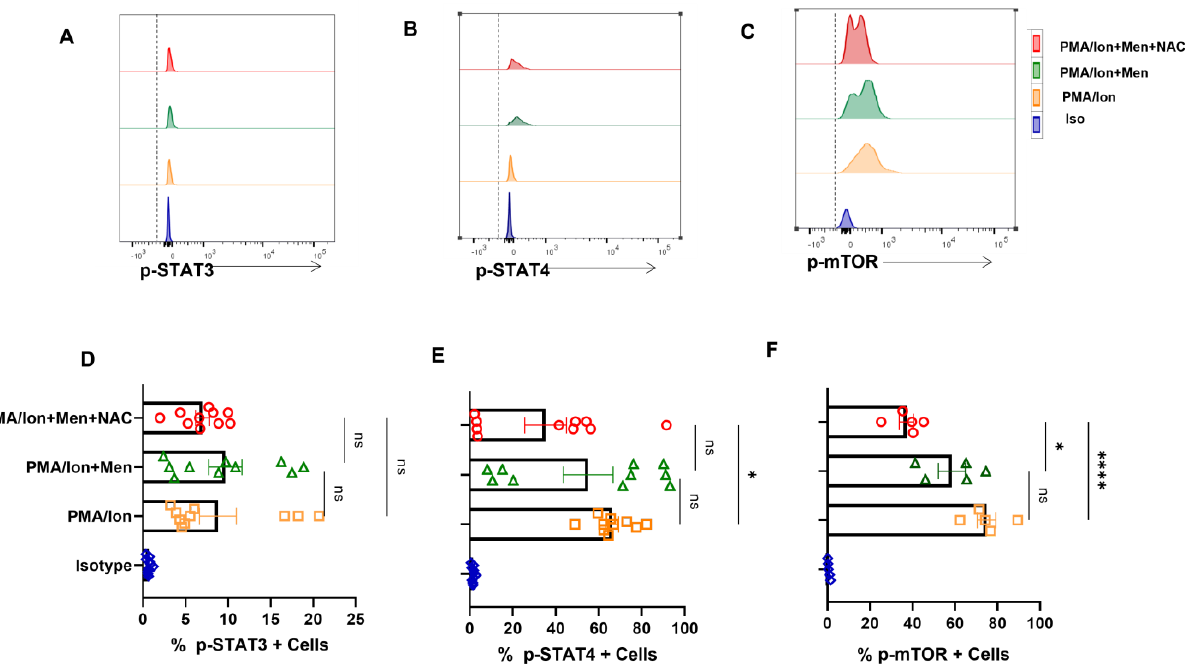
Figure 5. Antioxidant alters expression of p − STAT4 and p − mTOR from SLE CD8 + T cells. CD8 + T cells were isolated from the PBMCs of SLE patients and treated with 2.5 μM menadione with or without NAC for 4 h and processed according to the protocol mentioned in the method section. Representative figure showing no modulation in p − STAT3 expression when treated with PMA/Ion, menadione (2.5 μM) or NAC (5 Mm) ( A ). Representative figures showing a reduction in p − STAT4 ment with m enadione (2.5 μM ) ( B , C ). Cumulative graphical representation showing changes in